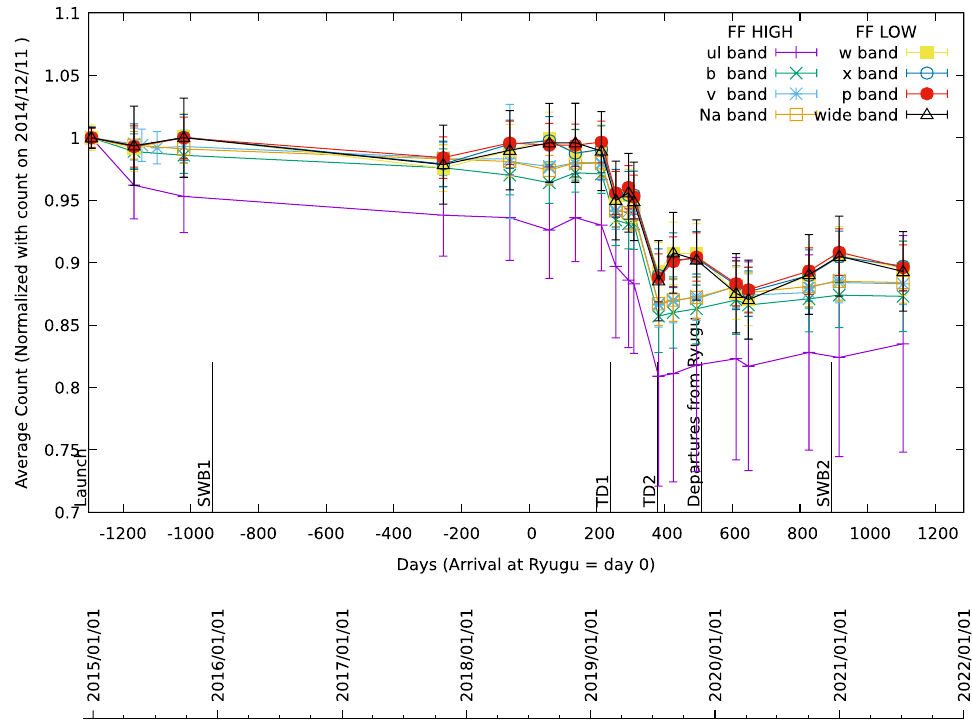
Fig. 2 History of ONC-T sensitivity changes from launch to July